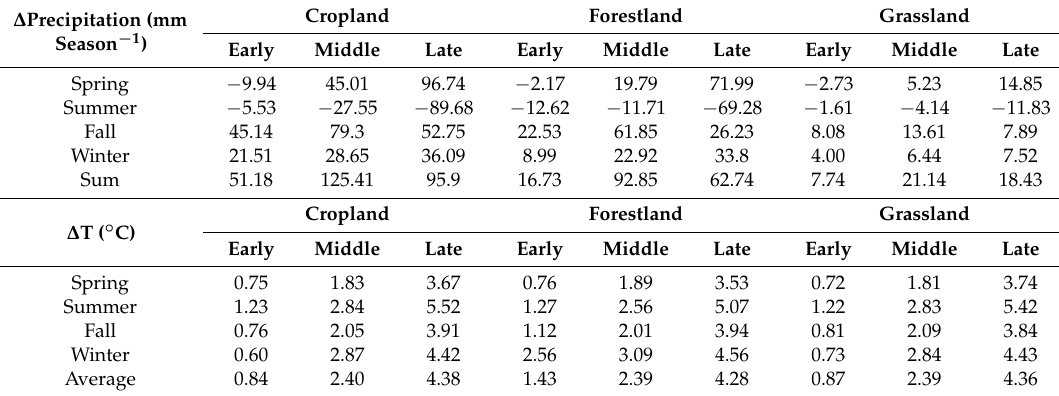
Table 4. Seasonal changes of precipitation and air temperature of three land covers over three future periods under A2